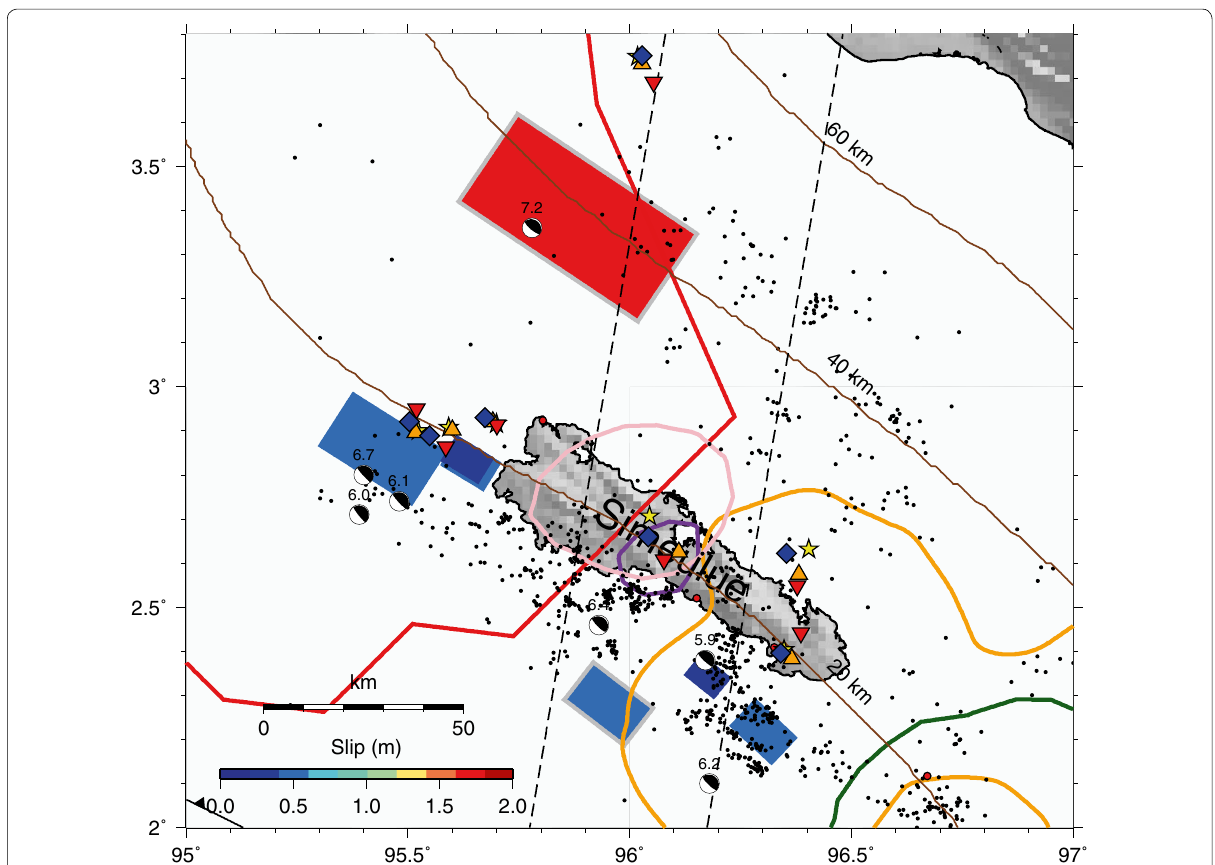
Fig. 6 Map of seven modeled earthquakes in the Simeulue section. Rectangular colored patches represent our final slip models, and the models elaborated upon in the main text are highlighted with a gray border. Yellow stars, orange triangles, blue diamonds, and red inverted triangles represent the epicenters from the ANSS, ISC, ISC-EHB, and ISC-GEM teleseismic catalogs, respectively. Black dots indicate seismicity between October 2005 and March 2006 located by Tilmann et al. (2010). See Fig. 1 caption for description of other